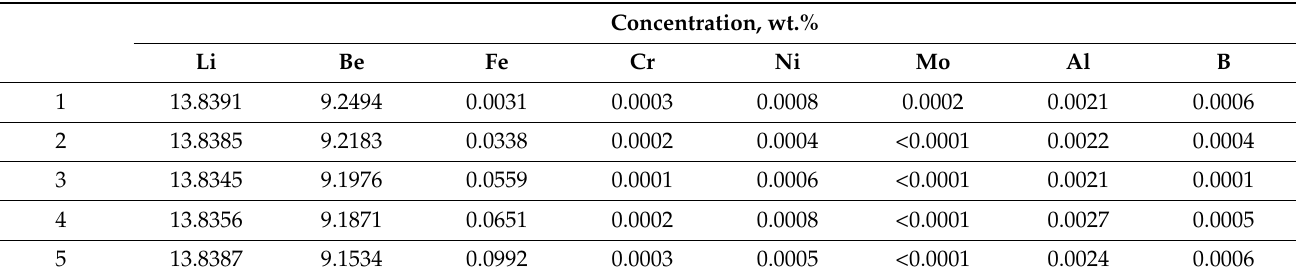
Table 1. Elemental analysis of the studied melts. Concentration, wt.%